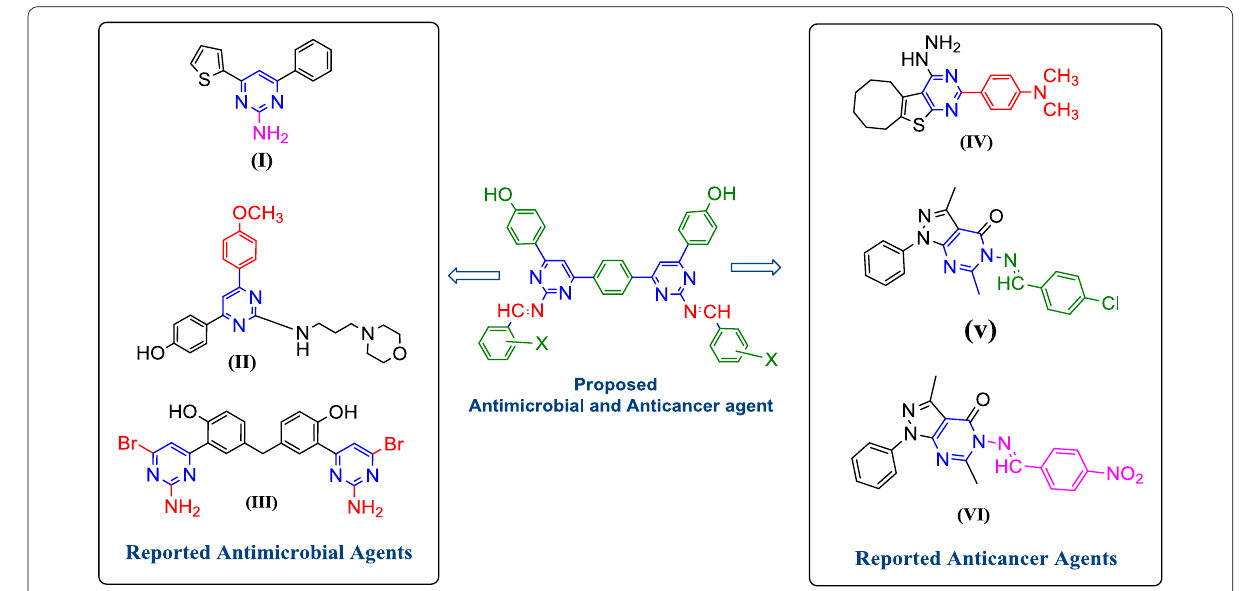
Fig. 2 Design of heterocyclic bis-pyrimidine derivatives for antimicrobial and anticancer activity based on